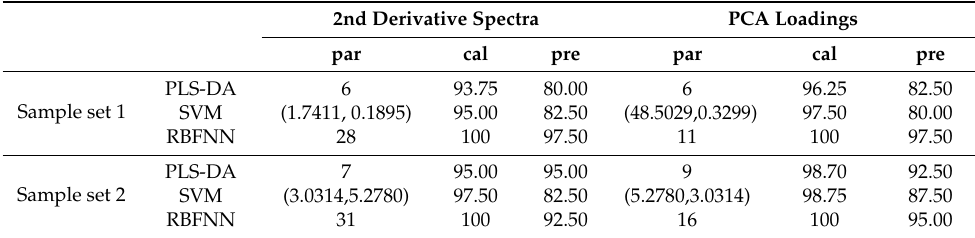
Table 3. Results of discriminant models using optimal wavelengths of sample set 1 and 2.